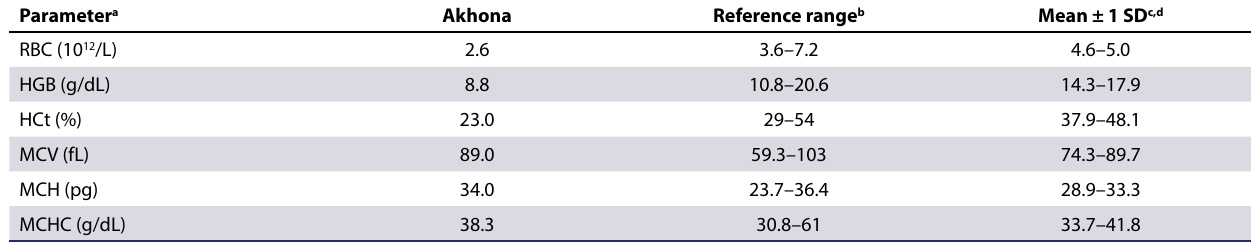
Table I: Haematological parameters of female black rhinoceros ‘Akhona’ two weeks (13 April) after being treated against babesiosis Parameter a